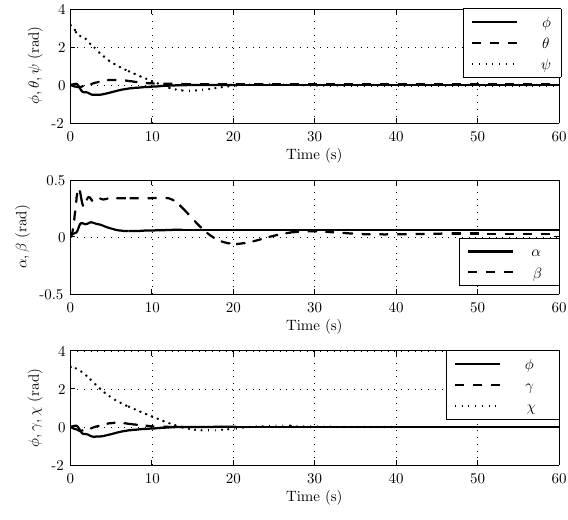
Figure 7: Angular